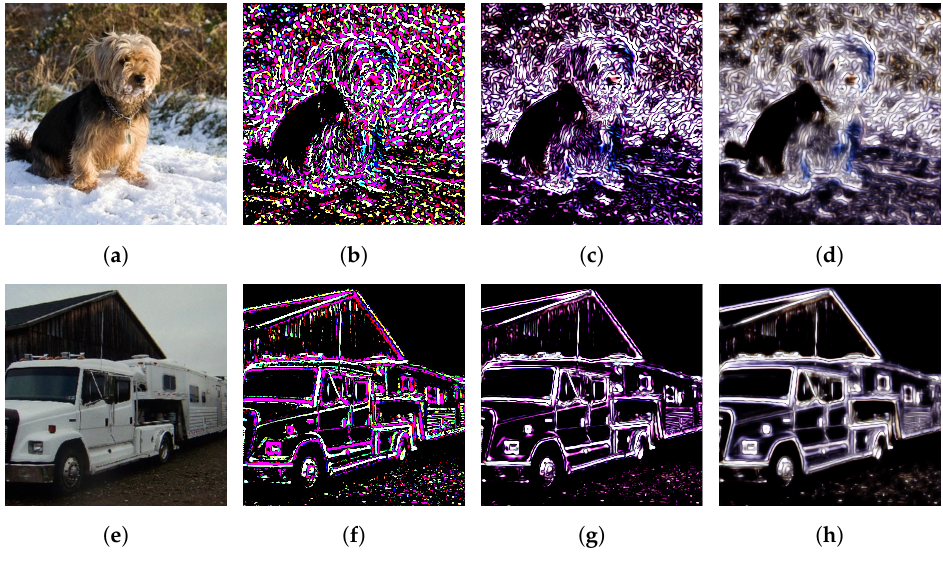
Figure 15. ITC attention after